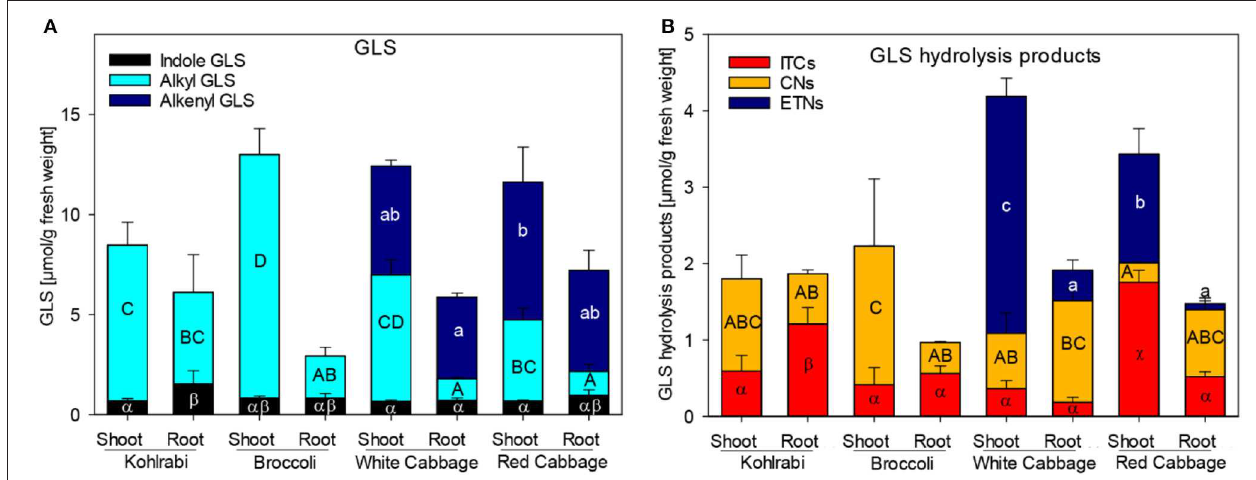
FIGURE 1 | Glucosinolate (GLS) accumulation (A) and formation of hydrolysis products (B) in shoots and roots of four B. oleracea genotypes. ITCs, isothiocyanates; CNs, nitriles; ETNs, epithionitriles. Values represent mean ± standard deviation (SD) of three independent experiments (n = 3). Significant differences in means between the formation of), alkenyl GLS (small letters), alkyl GLS (capital letters), and indole GLS (Greek letters) in (A) or ETNs (small letters), CNs (capital letters), or ITC (Greek letters) in (B) as tested by ANOVA and Tukey HSD test at the p ≤ 0.05